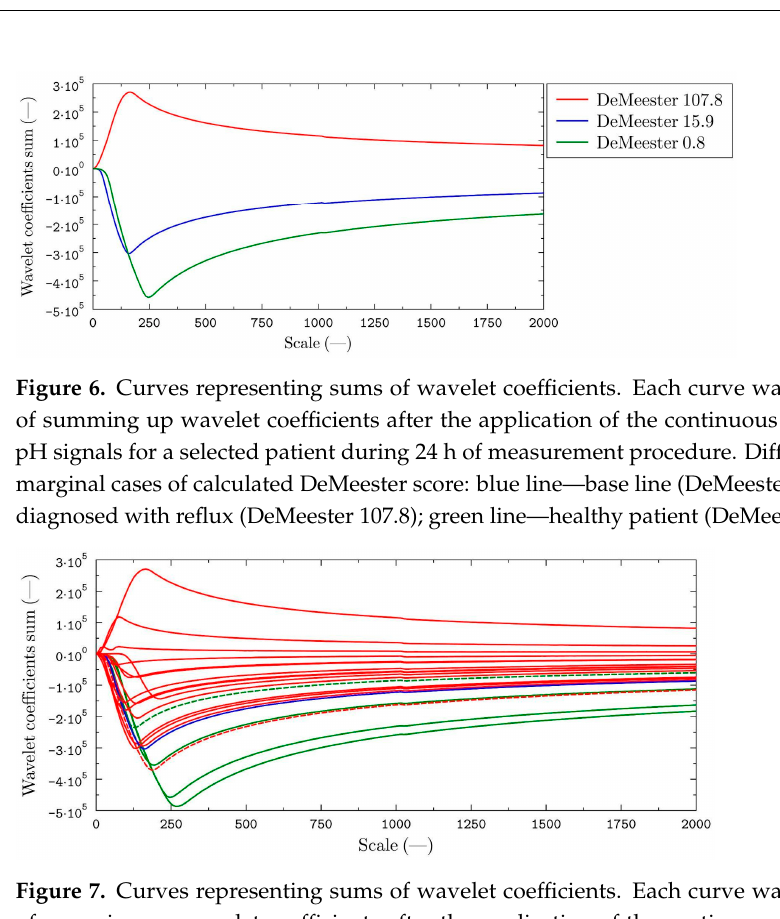
Figure 5. Scalograms of pH-metry signals obtained for Haar wavelet related to the 24-h measurement procedure. Scalograms show the result of the continuous wavelet transform, based on pH signals for the marginal cases of calculated DeMeester score.